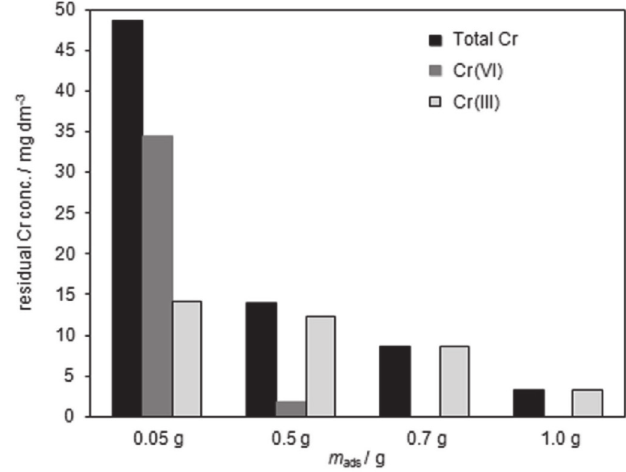
Fig. 7 – Influence of adsorbent concentration on concentra- tion of Cr(VI) ions and Cr(III) ions in aqueous solution (γ